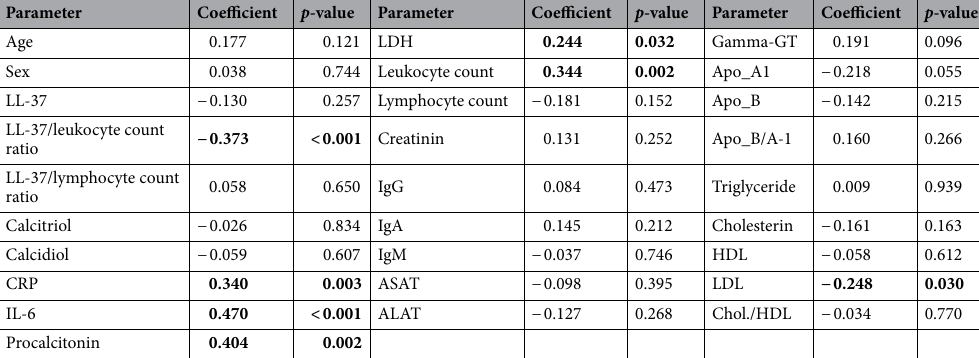
Table 2. Correlation of quantitative factors with the severity of COVID-19. The Spearman correlation of each parameter with COVID-19 severity. Listed are the correlation coefficients and p-values. Significant differences are shown in